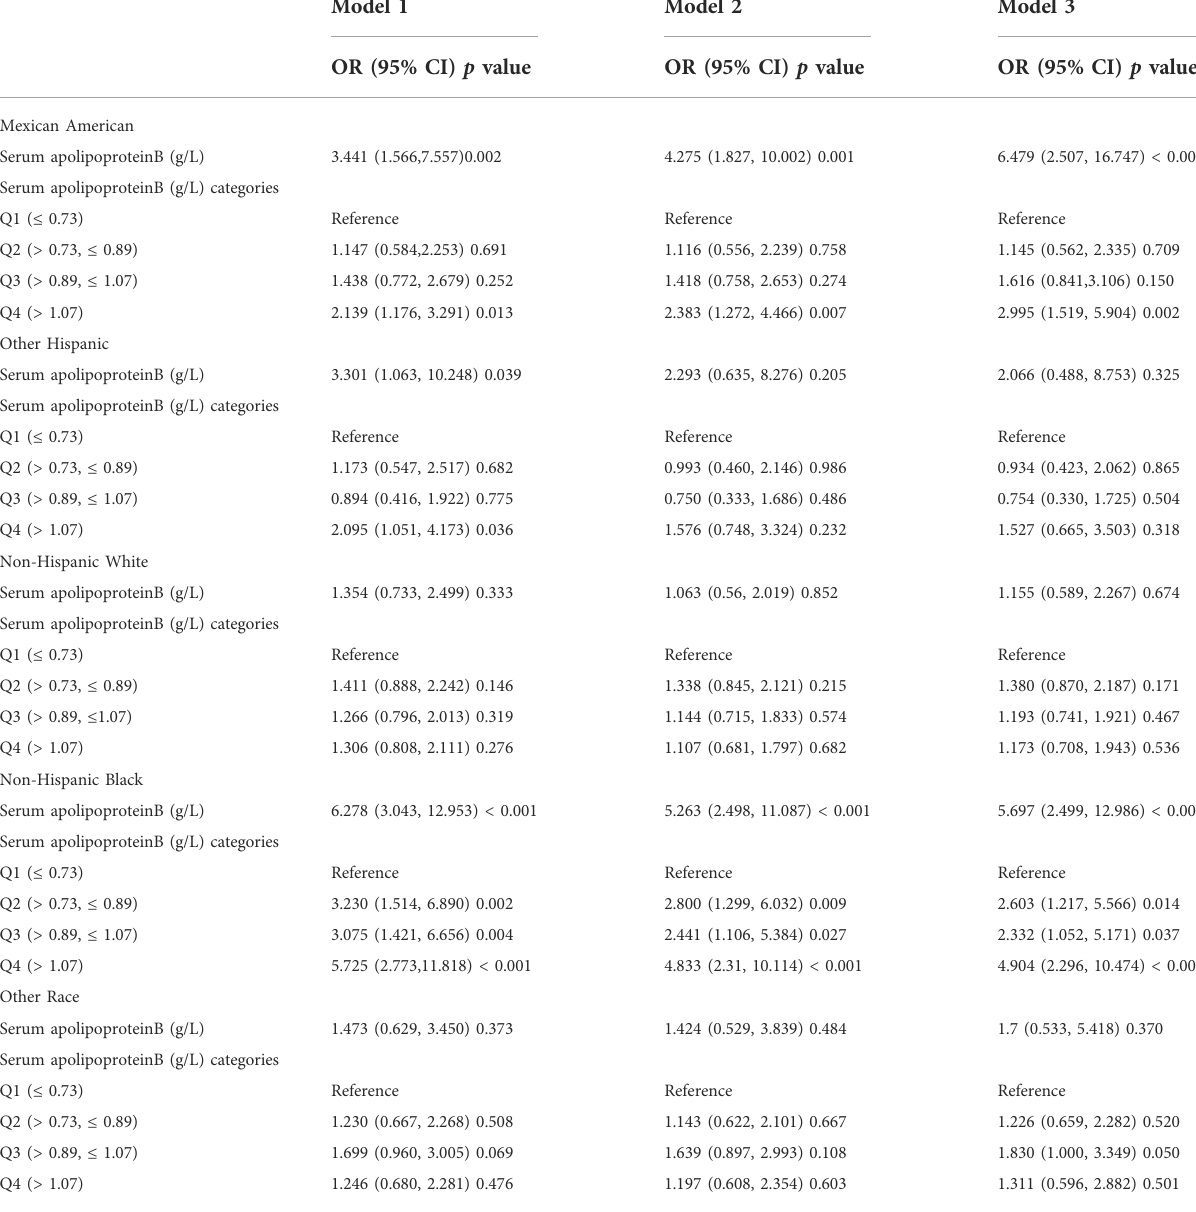
TABLE 9 Association between Serum apolipoprotein B (g/L) and the risk of osteopenia or osteoporosis (subgroup analysis strati fi ed by